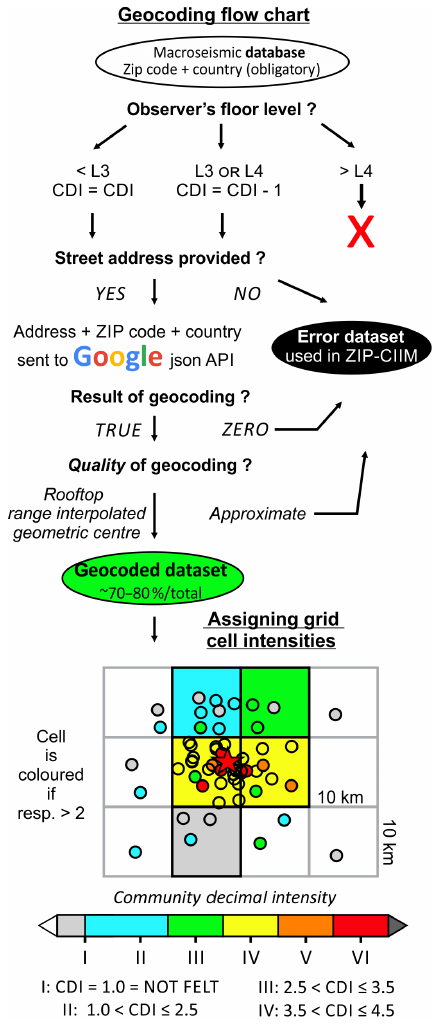
Figure 2. Geocoding flow chart and grid cell intensity procedure. Input addresses are send to a Google ™ JSON API in which ad- dresses are corrected and geocoded. Precision of the geocoded co- ordinates is quantified by a quality factor. For absent, unrecognized or imprecise (too low-quality) addresses, the geocoded response is not used for grid cell intensity assessment. All geocoded addresses are grouped within 100km 2 grid cells. Cells with at least three re- sponses are coloured to the mean